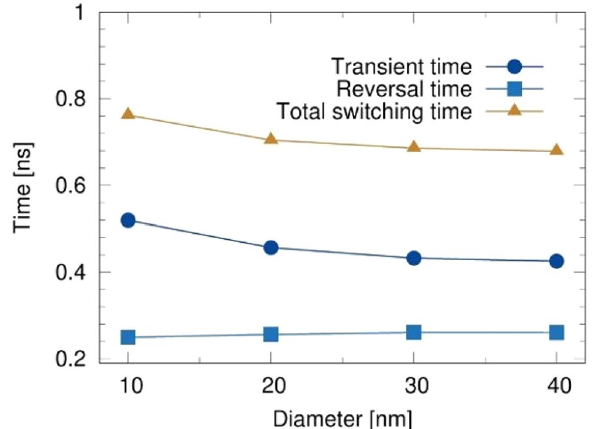
Figure 4. Magnetization reversal time in free layer of MTJ with different diameters injected by charge current 0 K. The reversal time is dominated by the transient time which relates to the density of 10 MA/cm 2 at T = lower demagnetizing field for the small diameter MTJs, while the reversal time is not strongly dependent on the